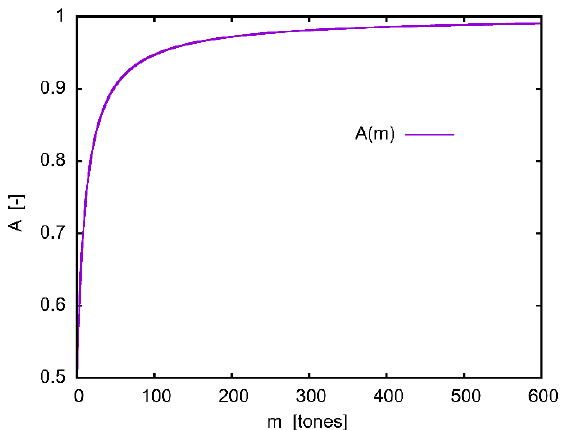
Figure 1. Parameter 𝐴 vs. generator aircraft mass 𝑚 , assuming linearity between wing lay-out area 𝑆 and 𝑚 as in [39].